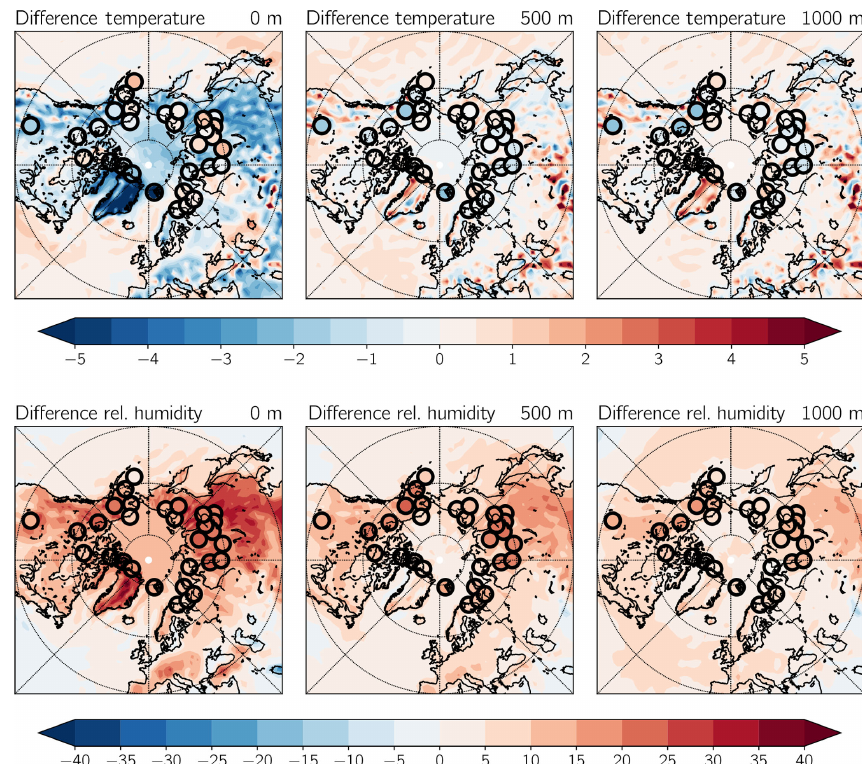
Figure A1. Vertical profiles of temperature and relative humidity differences between ECHAM6 and ERA-Interim averaged from 2007 to 2010. Filled circles show the same differences for profiles derived from radiosonde data. The vertical coordinate is height above ground level